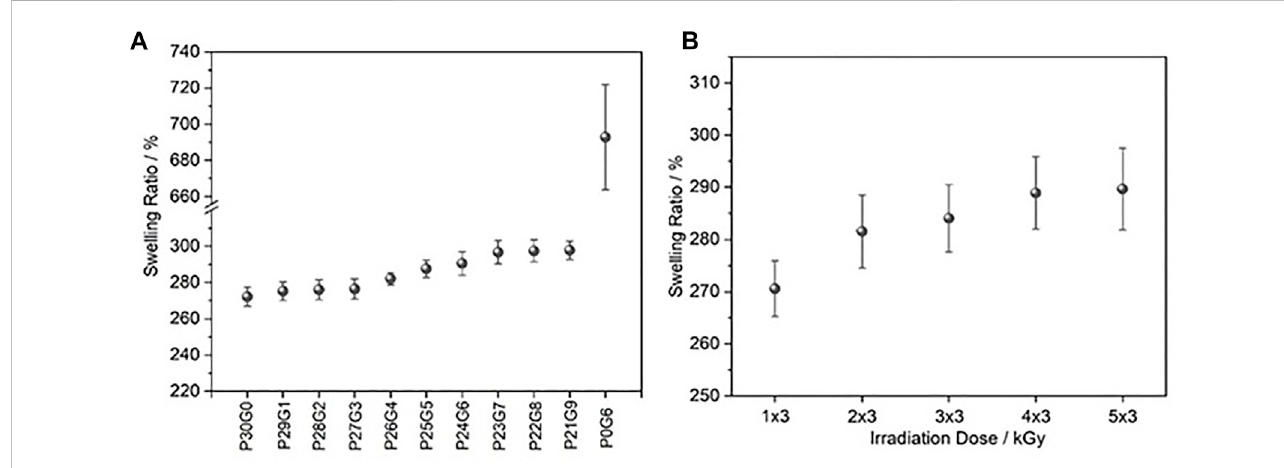
FIGURE 4 Gel fraction ratio of hydrogels (A) at different PEGDA/gelatin ratios and electron doses of 6 kGy and (B) with fi xed PEGDA/gelatin ratio of P26G4 after polymerization with different irradiation doses. Error bars indicate standard deviations.